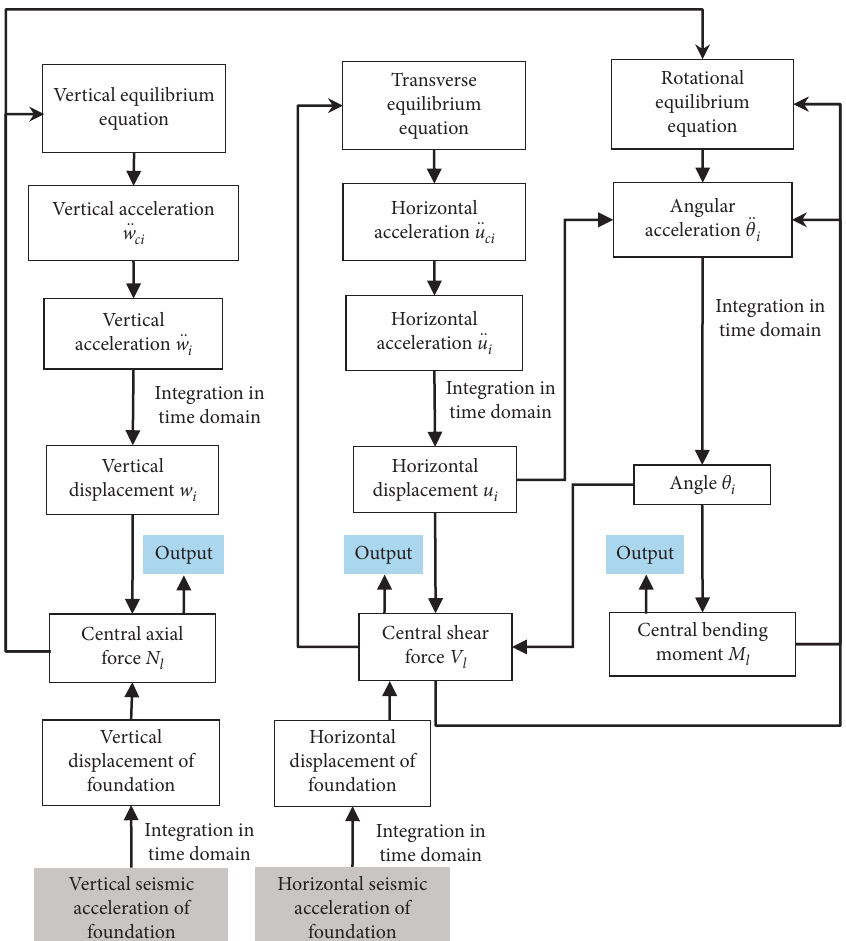
Figure 4: Algorithm description